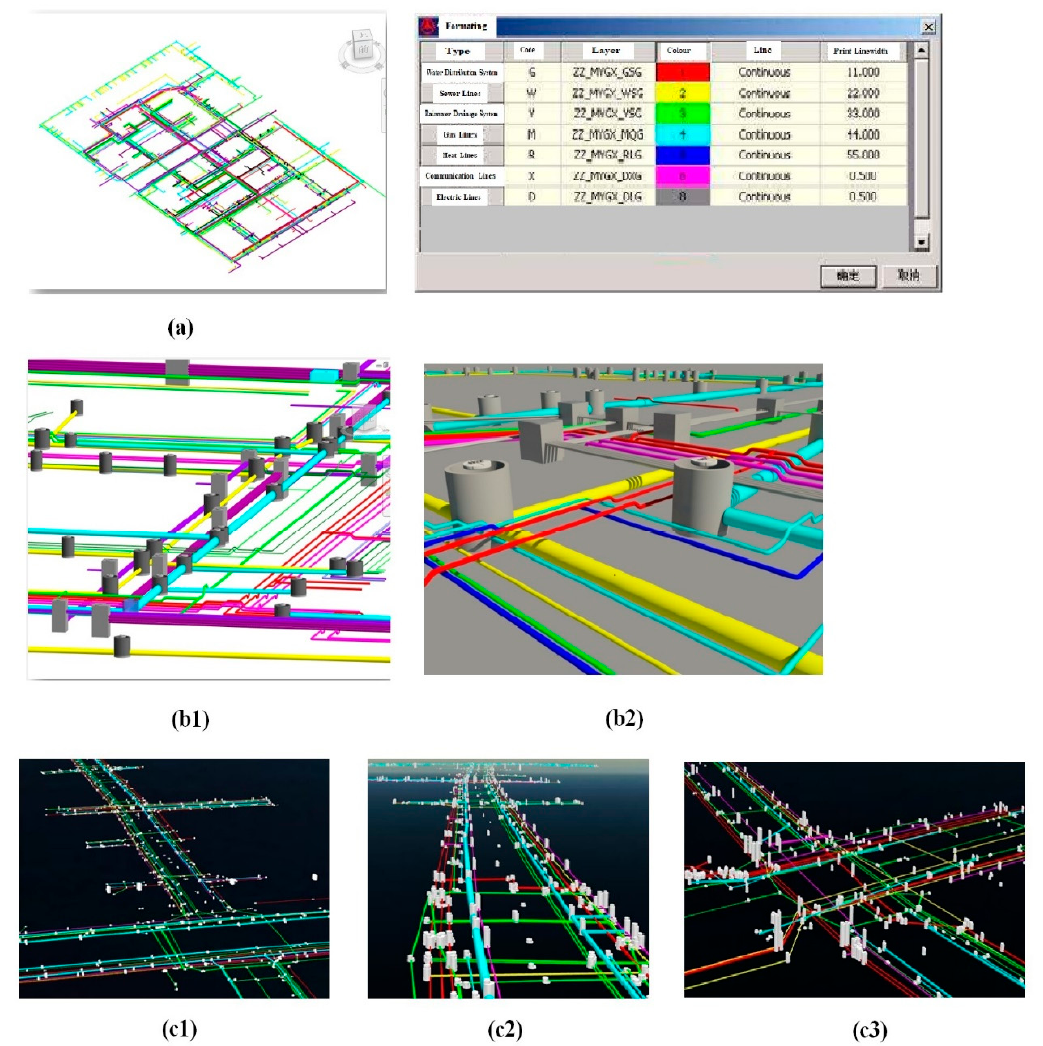
Figure 12. ( a ) The pipe systems in 2D drawings; ( b1 , b2 ) 3D model of the pipe systems in building information modeling (BIM); ( c1 – c3 ) 3D model of pipe systems in Figure 12. (a) The pipe systems in 2D drawings; (b1,b2) 3D model of the pipe systems in building information modeling (BIM); (c1–c3) 3D model of pipe systems in GIS.